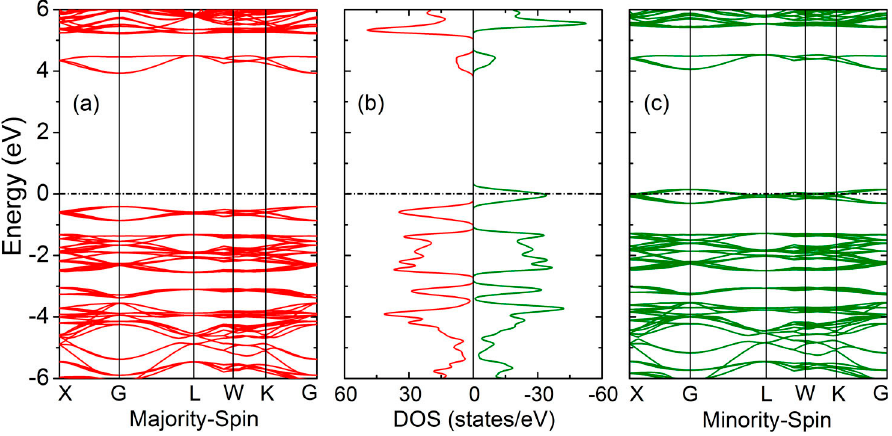
Figure 5. Band structure and density of states (DOS) of GaFe(CN) 6 at 0 GPa.